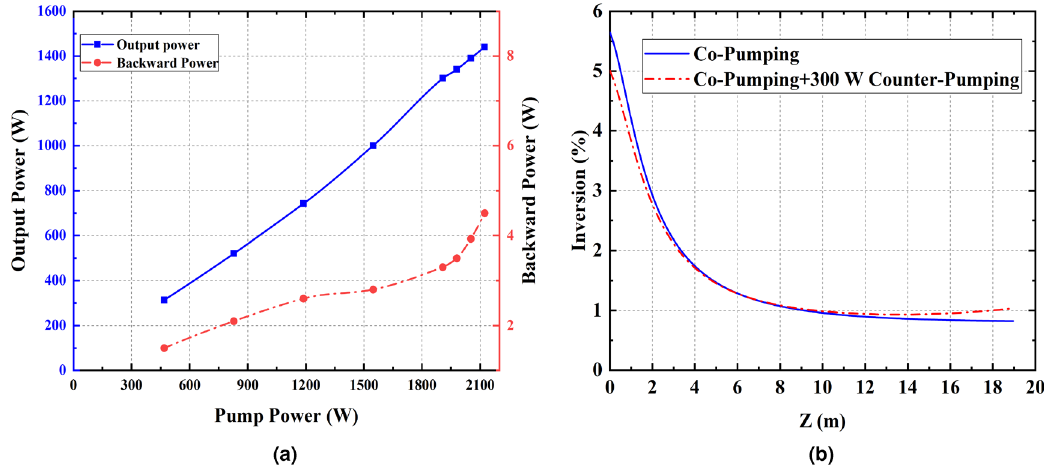
Figure 5. ( a ) Laser output and backward power versus pumping power in bidirectional-pumping setup. Compared with co/counter-pumping setup, The threshold of TMI effect is increased patently ( b ) Comparison of co and bidirectional pumping inversion level